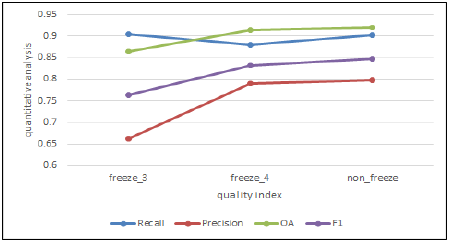
Figure 12. The learning rate of frozen convolutional